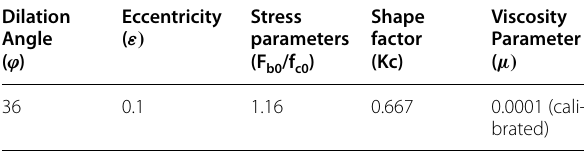
Table 7 Damage properties of concrete.